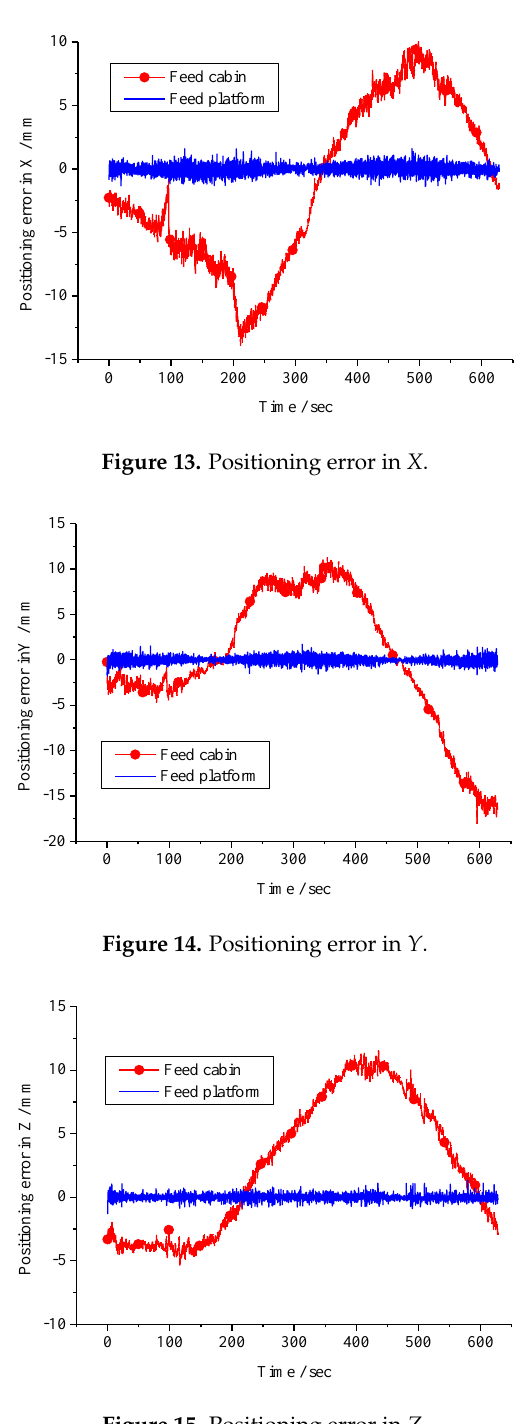
Figure 15. Positioning error in Z Figure 15 . Positioning error in Z.